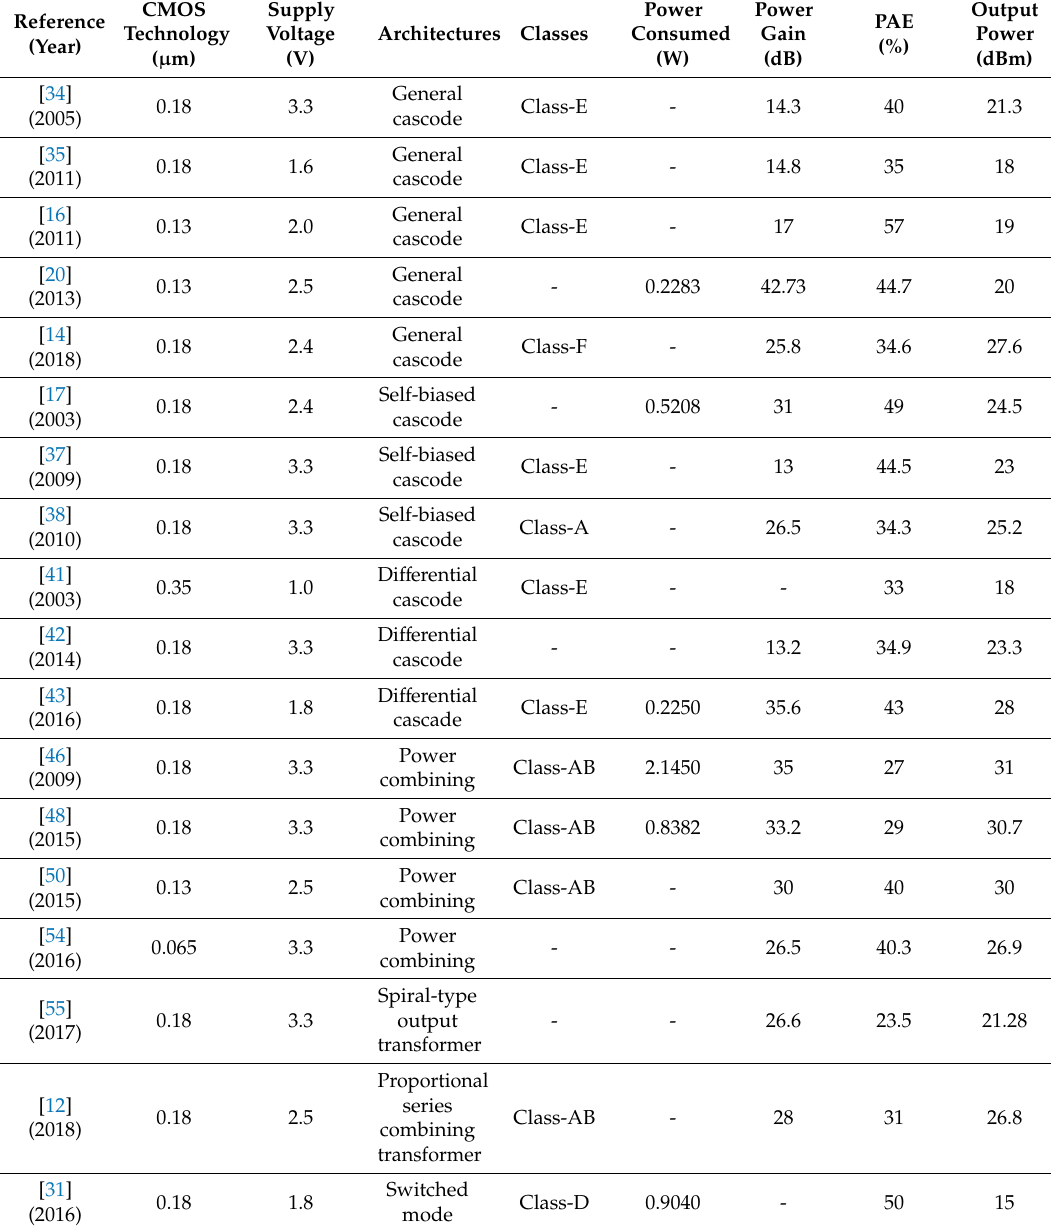
Table 2. Performance comparison of 2.4 GHz CMOS